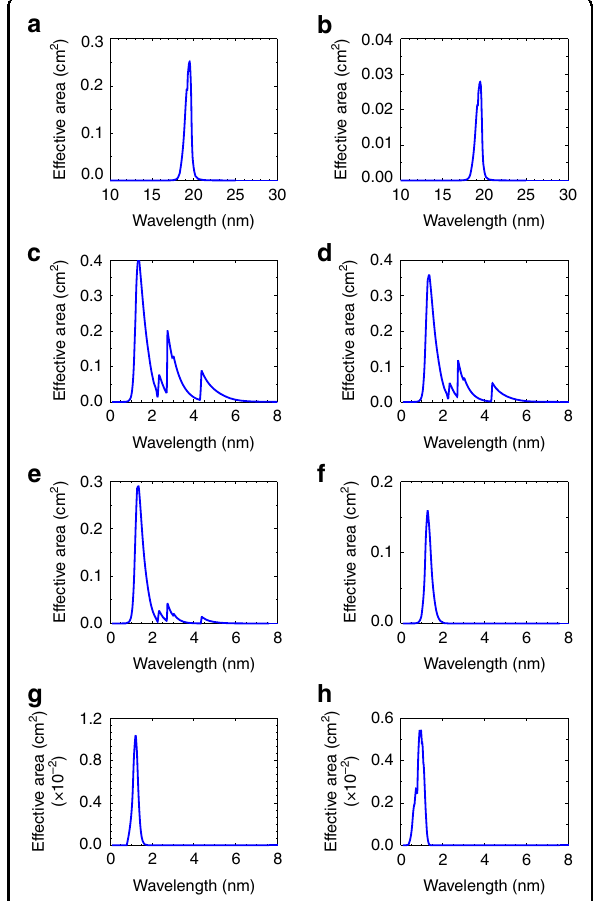
Fig. 11 Effective area distribution of X-EUVI. a EUV1 band, b EUV2 band, c X1 band, d X2 band, e X3 band, f X4 band, h X5 band, and g X6